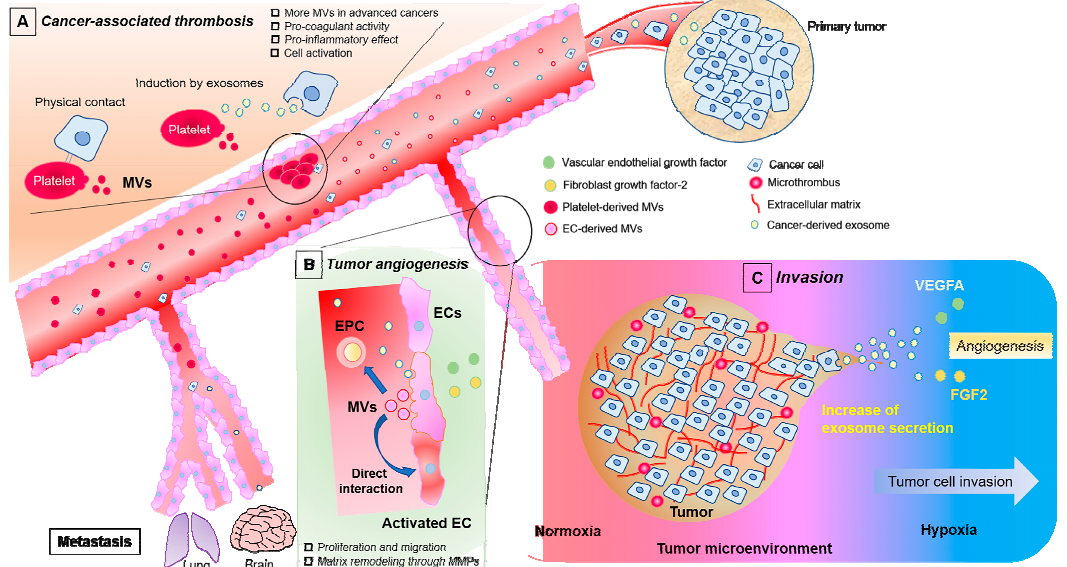
Figure 1. Involvement of ECs, platelets, and EVs in cancer progression, including angiogenesis, invasion, and metastasis. EVs play important roles in these processes through their function of cell-to-cell communication. Cancer cells develop favorable microenvironments by promoting angiogenesis and procoagulant and proinflammatory activities via the secretion of exosomes and hypoxia-induced growth factors. Platelets are activated via physical contact with cancer-derived exosomes, thereby resulting in increased secretion of platelet-derived microvesicles and the subsequent development of coagulation ( A ). ECs are activated by VEGF-A and FGF-2 released from cancer cells under hypoxic conditions and by circulating cancer-derived exosomes. Activated ECs shed microvesicles and activate other ECs via the microvesicles and direct interaction ( B ). Hypoxia is involved in tumorigenesis. A hypoxic microenvironment created by cancer cells triggers the proangiogenic pathway that involves the cancer-derived exosomes secretion ( C ). Circulating cancer cells and EVs from cancer cells, platelets, and ECs are strongly associated with cancer progression, including metastasis. EC, endothelial cell; EV, extracellular vesicle; VEGF, vascular endothelia growth factor; FGF, fibroblast growth factor; MV, microvesicle; EPC, endothelial progenitor cell.